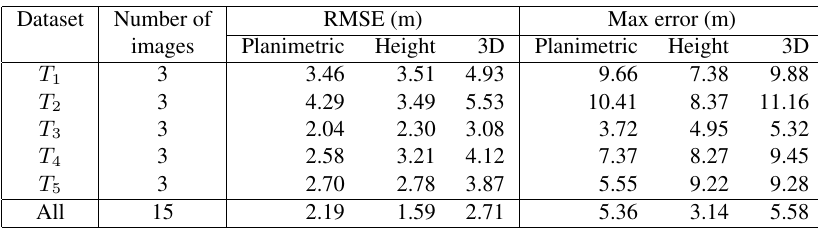
Table 2. Accuracy of object coordinates estimated by using the bias-corrected RPC model